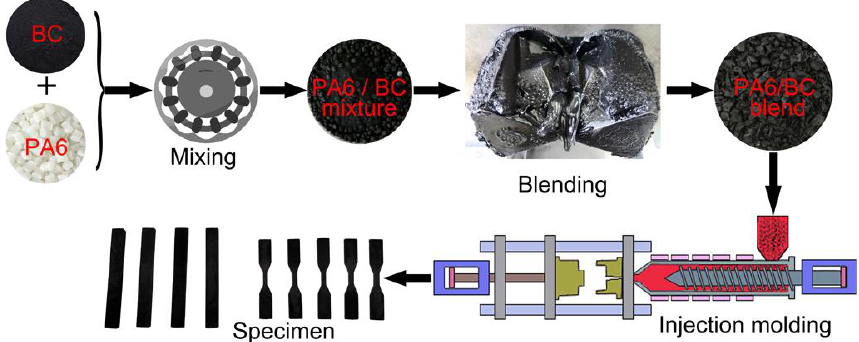
Figure 1. Processing diagram of polyamide 6/bamboo-based biochar (PA6/BC) composites.